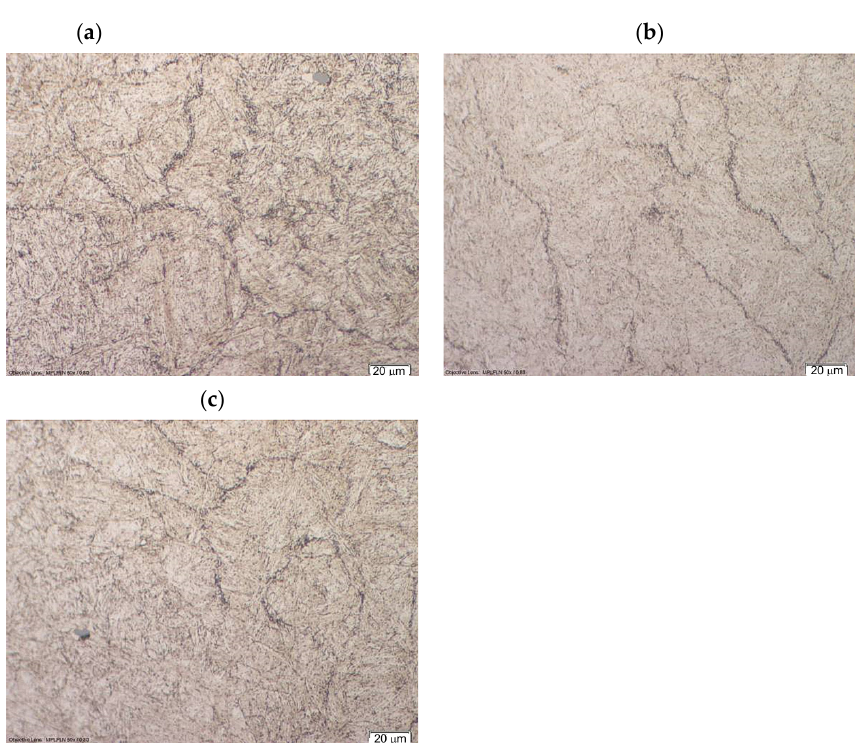
Figure 5. Microstructure of die insert (sample A6b) observed at: ( a ) XY plane, ( b ) ZX plane, ( c ) ZY plane.